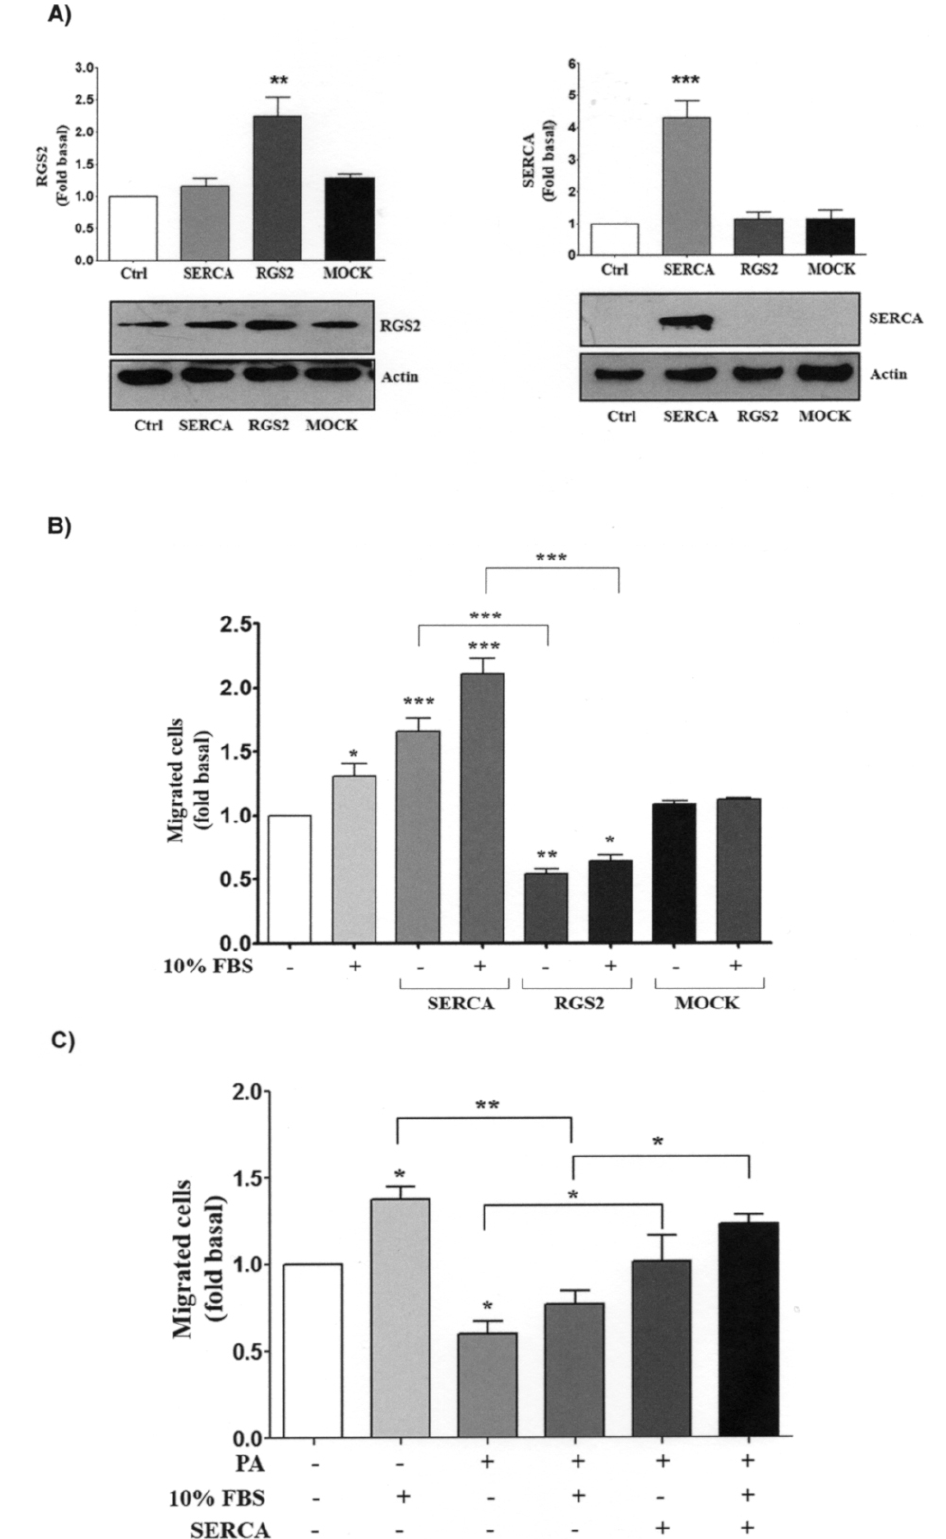
Figure 2 – SERCA overexpression prevented the decrease in PA-induced cell migration in HEK293 cells. HEK293 cells were transfected with a RGS2 and SERCA2 construct or with an empty vector (MOCK). a Cells were lysed and RGS2 and SERCA expression were analyzed by western blotting using anti-RGS2 and anti-SERCA2 Ab, respectively. Western blots were also probed for actin as a loading control. b HEK293 cells were untreated or treated with 10 % FBS (as a positive control of cell migration) and cell migration assays were performed by using the Boyden chamber method. The graphs represent the mean ± S.E.M. of migration of three independent experiments and are expressed as the fold of unstimulated cells. c HEK293 cells were transfected with a SERCA2 construct prior to incubation for 8 h with 0.25 mM PA. Cell migration assays were performed by using the Boyden chamber method. The graphs represent the mean ± S.E.M. of migration of three independent experiments and are expressed as the fold of control. * p <0.05, ** p <0.01, *** p <0.001 vs control condition (unstimulated